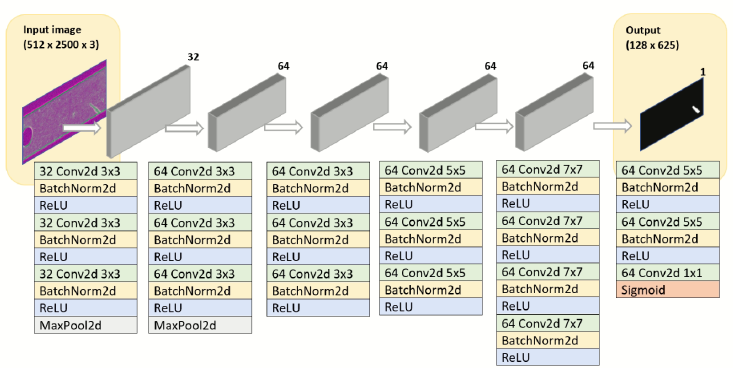
Figure 2. Defect segmentation network architecture.